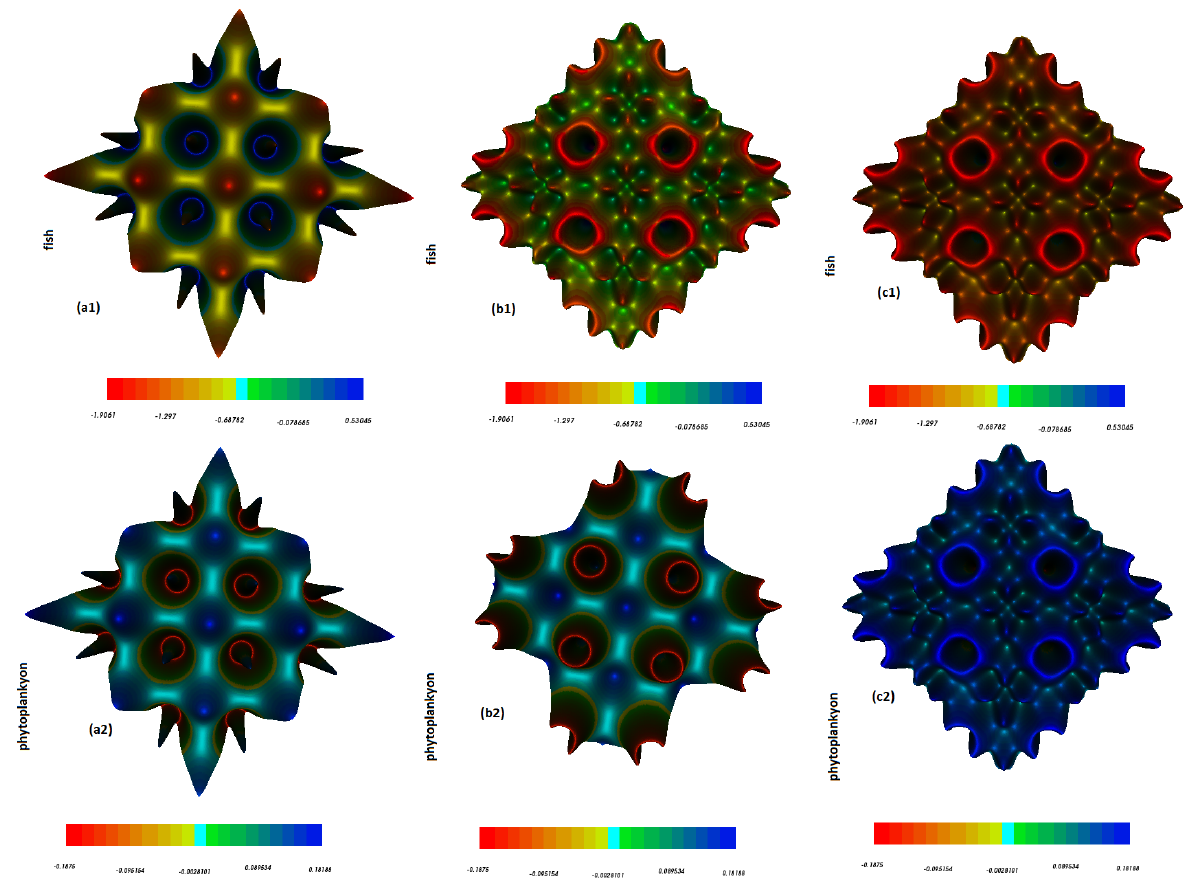
Figure 4. Dynamic behavior of two dimensional space: fish [first line] and phytoplankton [second line] population density of the model system (4). The diffusion coefficient values are δ 0 = 0.3; δ 2 = − 0.2, δ 3 = 0.4. Spatial distribution are obtained at different values δ 1 : for plot δ 1 = 19 ( a 1; a 2 ) ; δ 1 = 26 ( b 1; b 2 ) ; δ 1 = 34 ( c 1; c 2 )